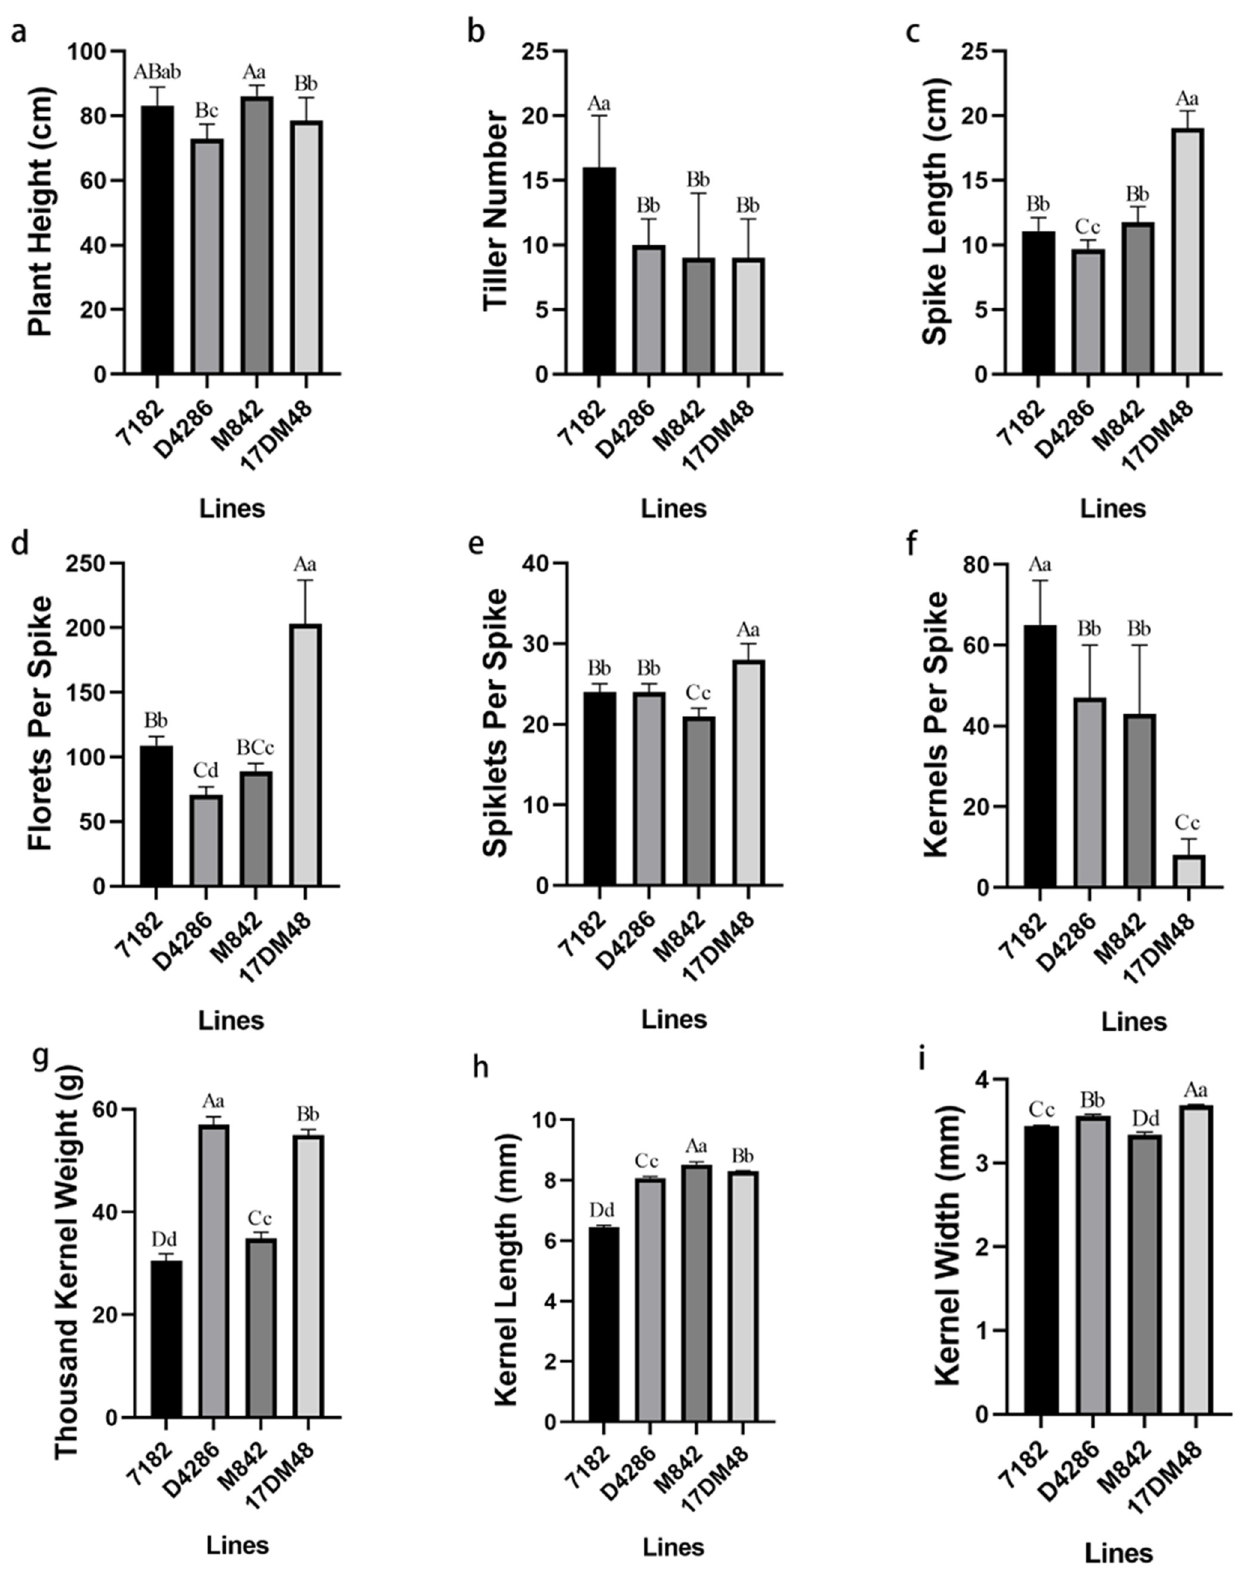
Figure 6. Analysis of agronomic traits of line 7182 and its parents. ( a ) plant height. ( b ) tiller number. ( c ) spike length. ( d ) florets per spike. ( e ) spikelets per spike. ( f ) kernels per spike. ( g ) thousand kernel weight. ( h ) kernel length. ( i ) kernel width. Capital and small letters indicate significant differences at p < 0.01 and p < 0.05, respectively.